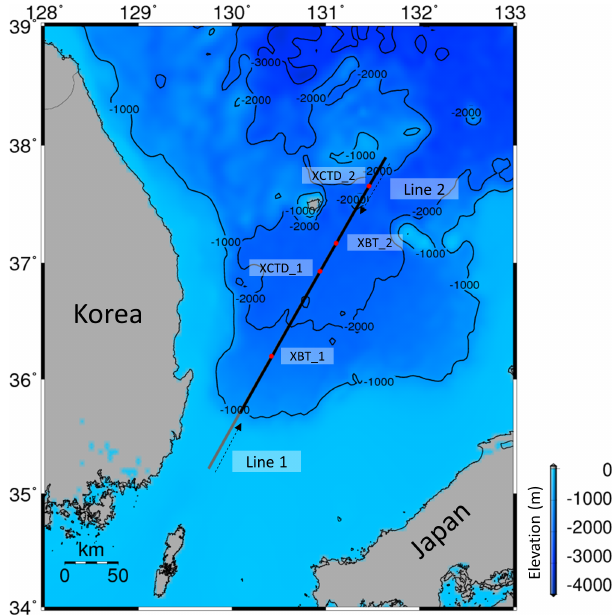
Figure 2. Location of seismic exploration. The solid gray and black line shows the survey line. The gray line indicates the shelf and slope parts, which were removed from the seismic section during data processing, and black line indicates the target area of this study. The dashed black lines with arrows indicate the exploration direc- tions of lines 1 and 2, and red dots are the locations of XBTs and